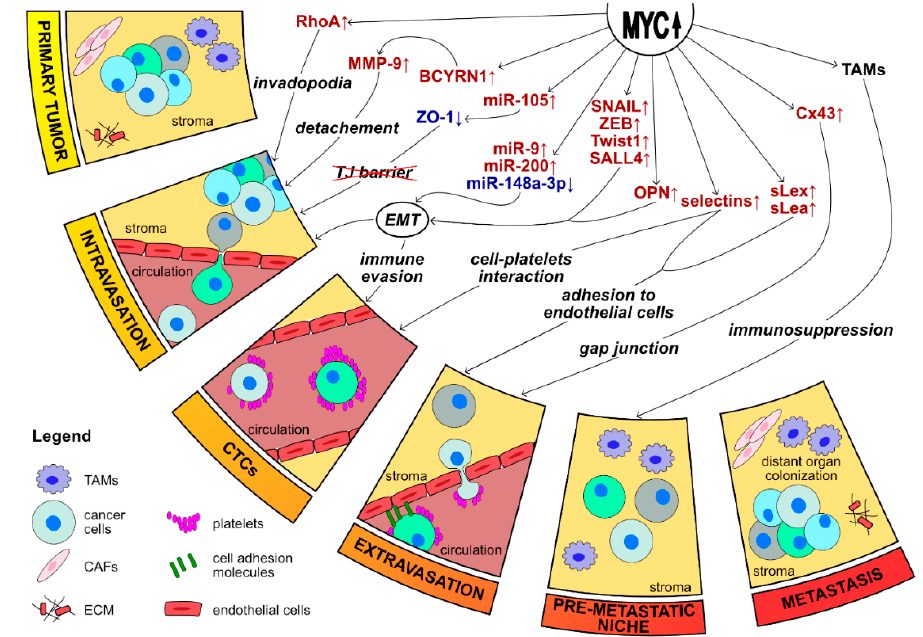
Figure 3. MYC is an important player in the formation of metastasis. Metastasis is a complex process involving the detachment from the primary tumor, intravasation into the bloodstream, survival within circulation, arrest, extravasation, and colonization at distant sites. MYC regulates metastasis formation using several different approaches—directly, co-operating with other oncoproteins, epigenetically, using a network of ncRNAs or recruiting components of the microenvironment. EMT seems to be at the center of MYC-induced metastasis [13,24,25,31,112,172,178,179,183,191,242] .